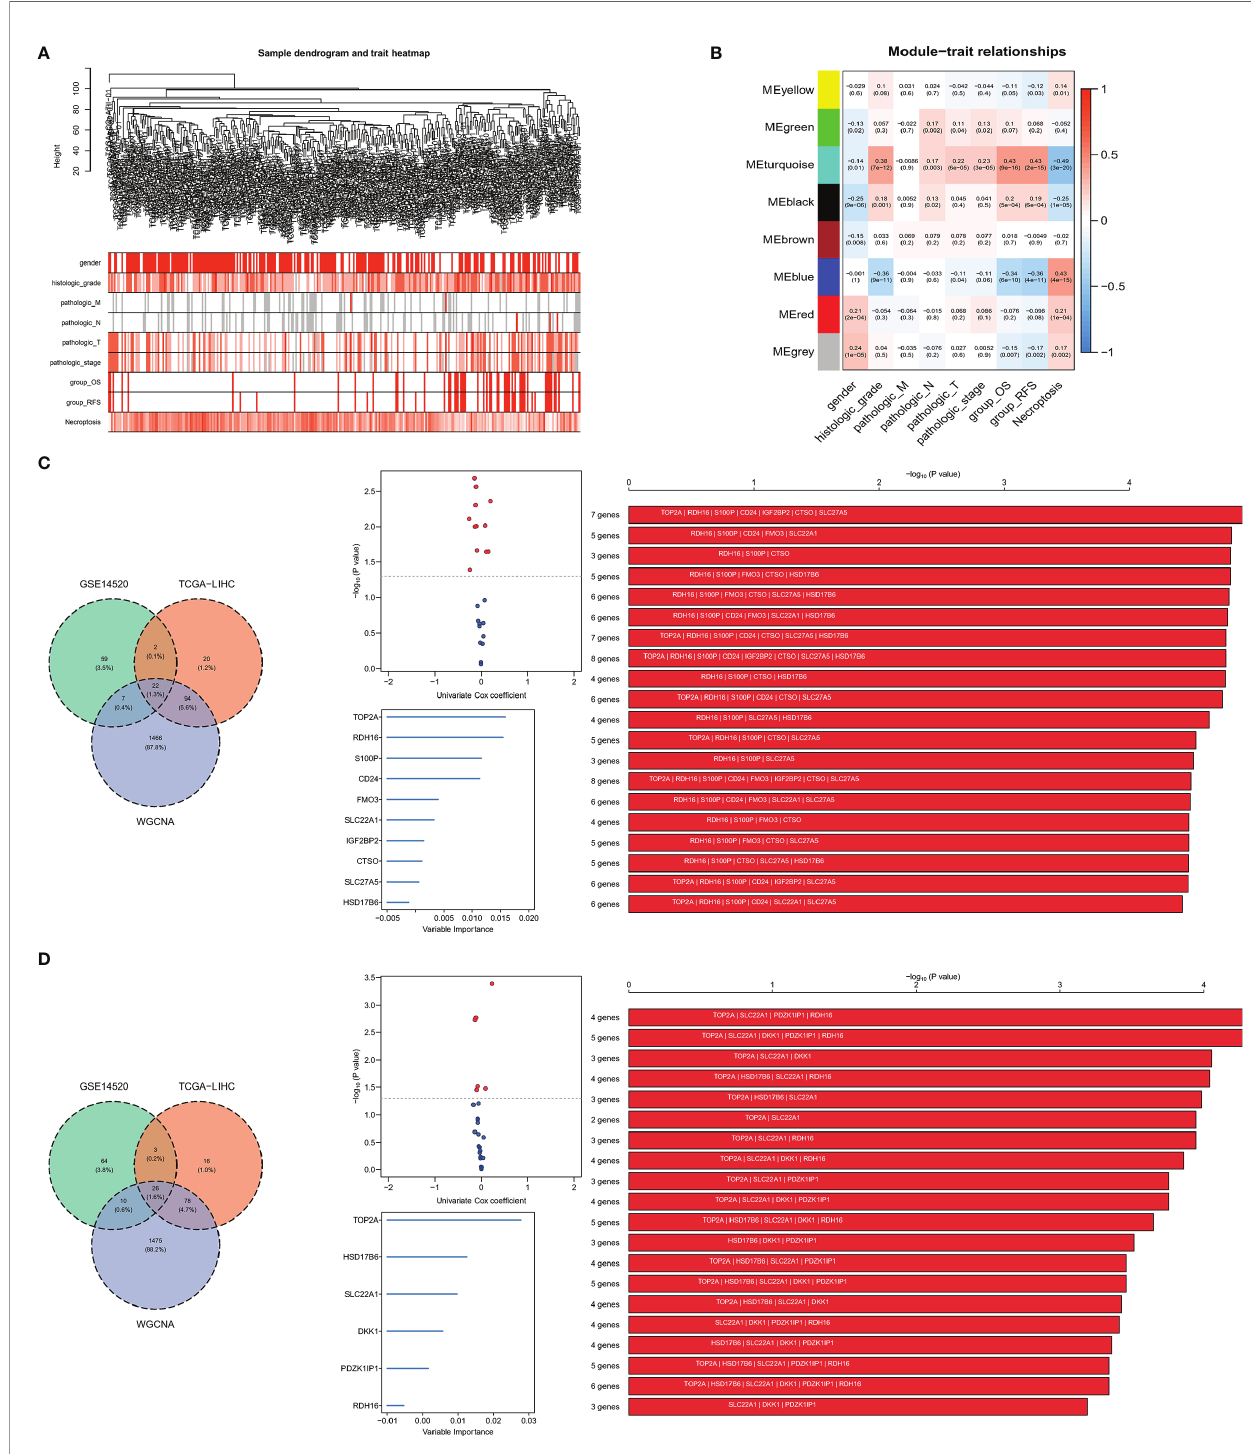
FIGURE 2 | Screening for necroptosis-related genes. (A) Clustering dendrogram. (B) Correlation between gene modules and necroptosis scores; (C, D) signature combination for predicting OS and RFS, the intersection of DEGs and selected module genes, volcano plot showed the genes of the intersection of the univariate Cox regression analysis, signature combination selected by random survival forest analysis and Kaplan – Meier